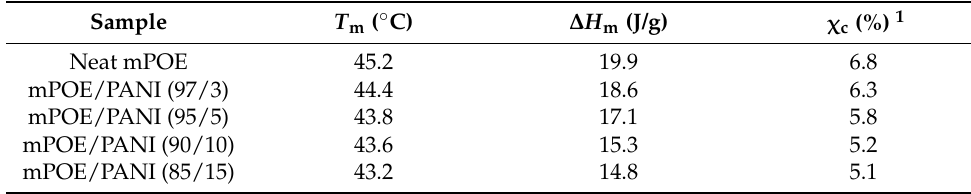
Table 1. Thermal characteristics of mPOE/PANI blends.